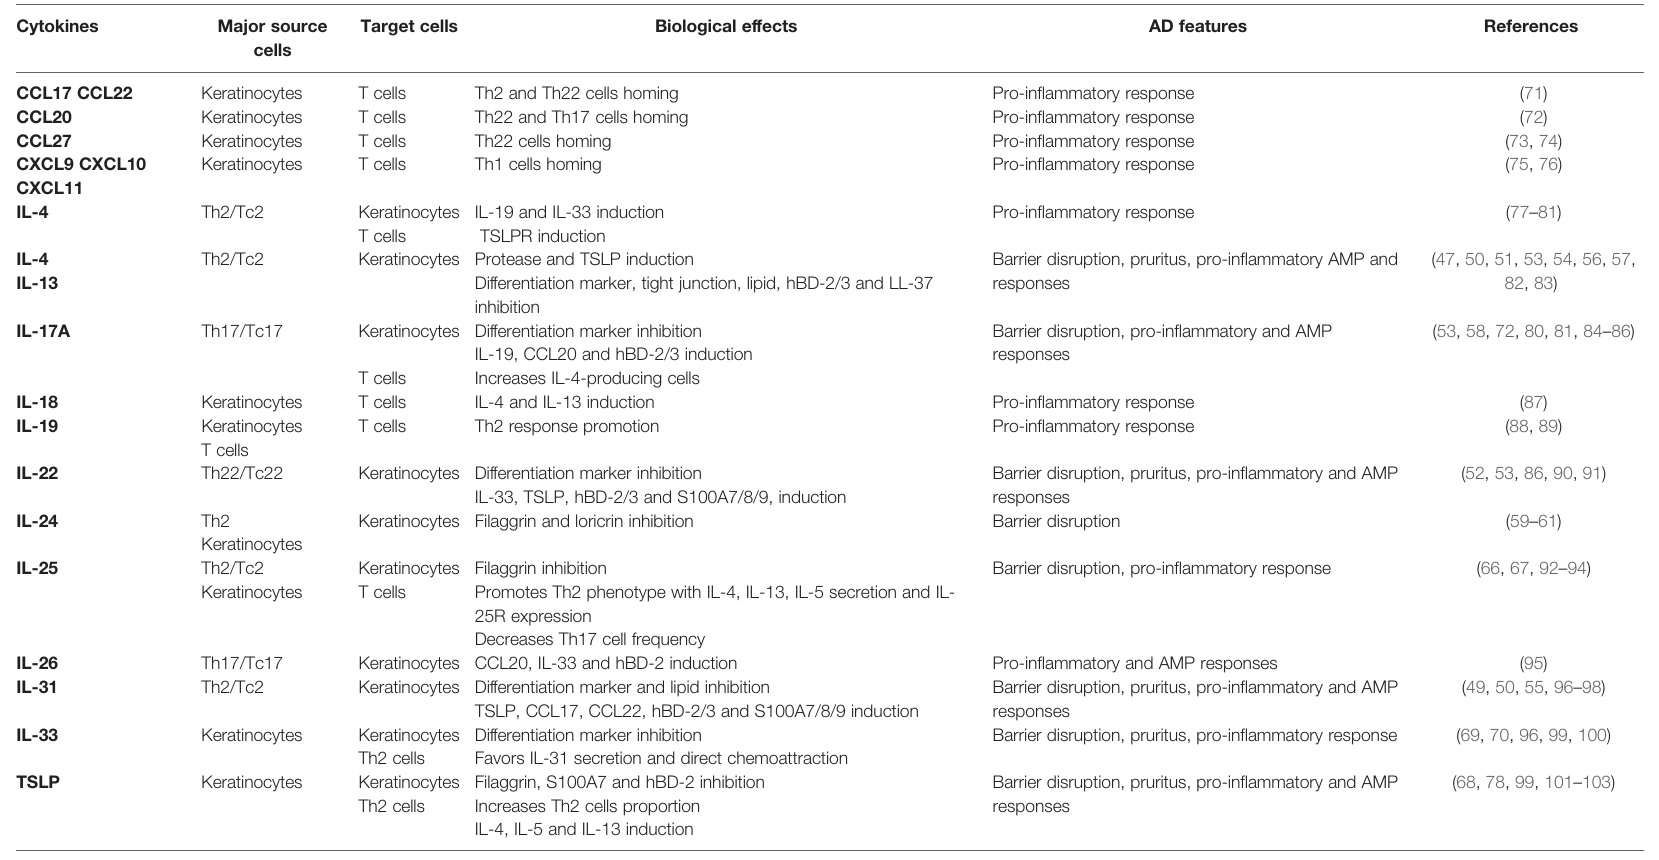
TABLE 1 | Role of cytokines produced by T cells and keratinocytes in AD